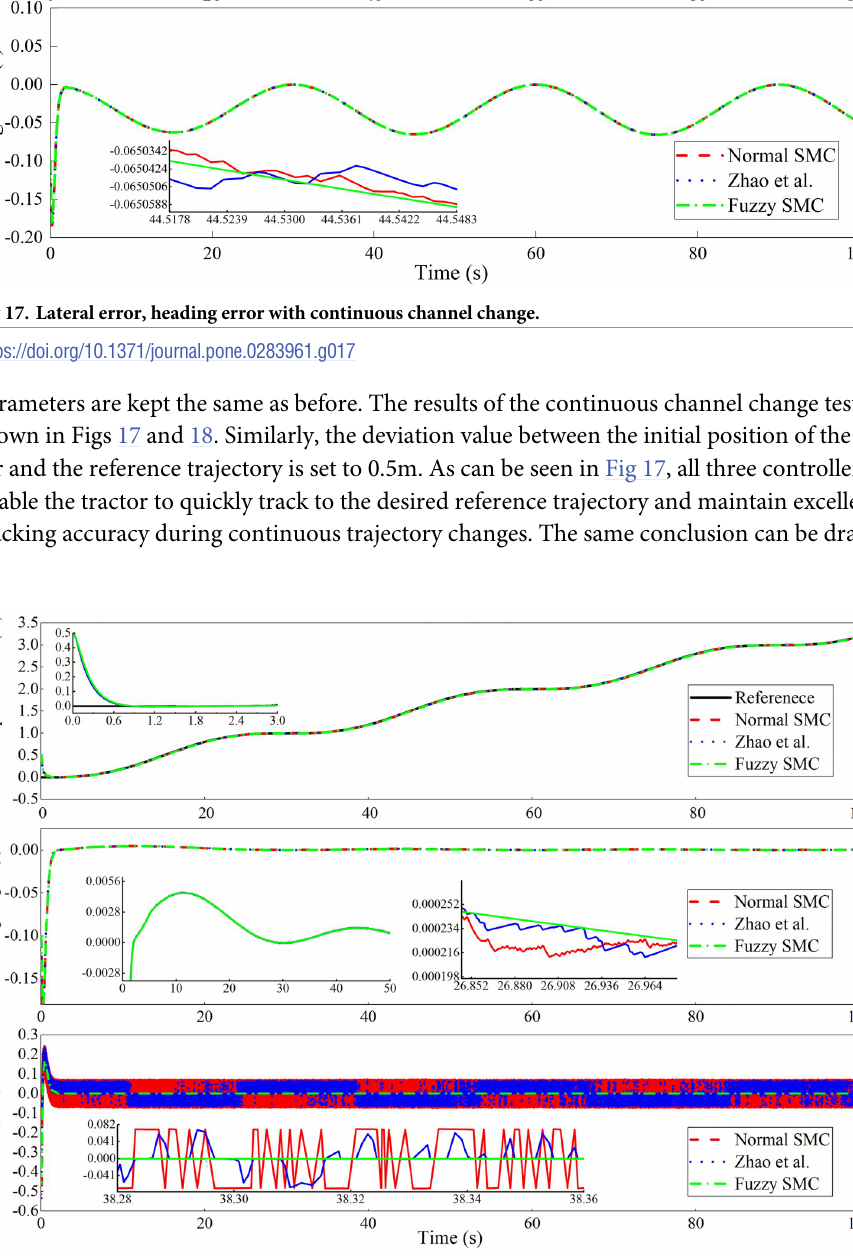
Fig 18. Lateral displacement, heading angle, steering angle with continuous channel